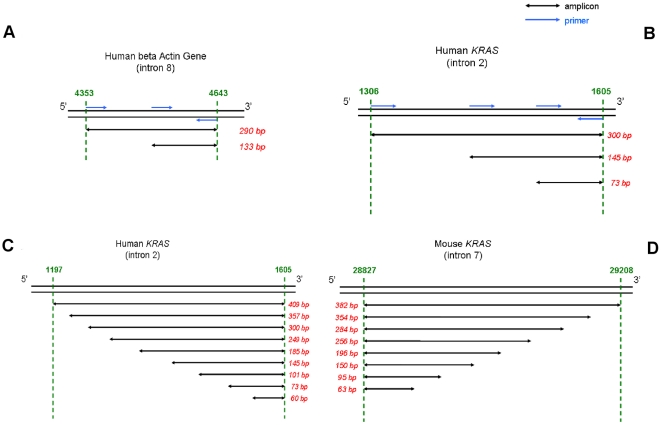
Primer designs used in the study.Primer targeting an ACTB region for quantifying ctDNA and determining ctDNA fragmentation from HT29 xenografted mice (A). Primer targeting a human KRAS region for studying the effect of the target sequence size on ctDNA concentration and fragmentation in plasma from SW620 xenografted mice (B). Primer design for studying the size distribution profile of ctDNA fragments in plasma from SW620 xenografted mice and human individuals by targeting human (C) and mouse (D) KRAS region.